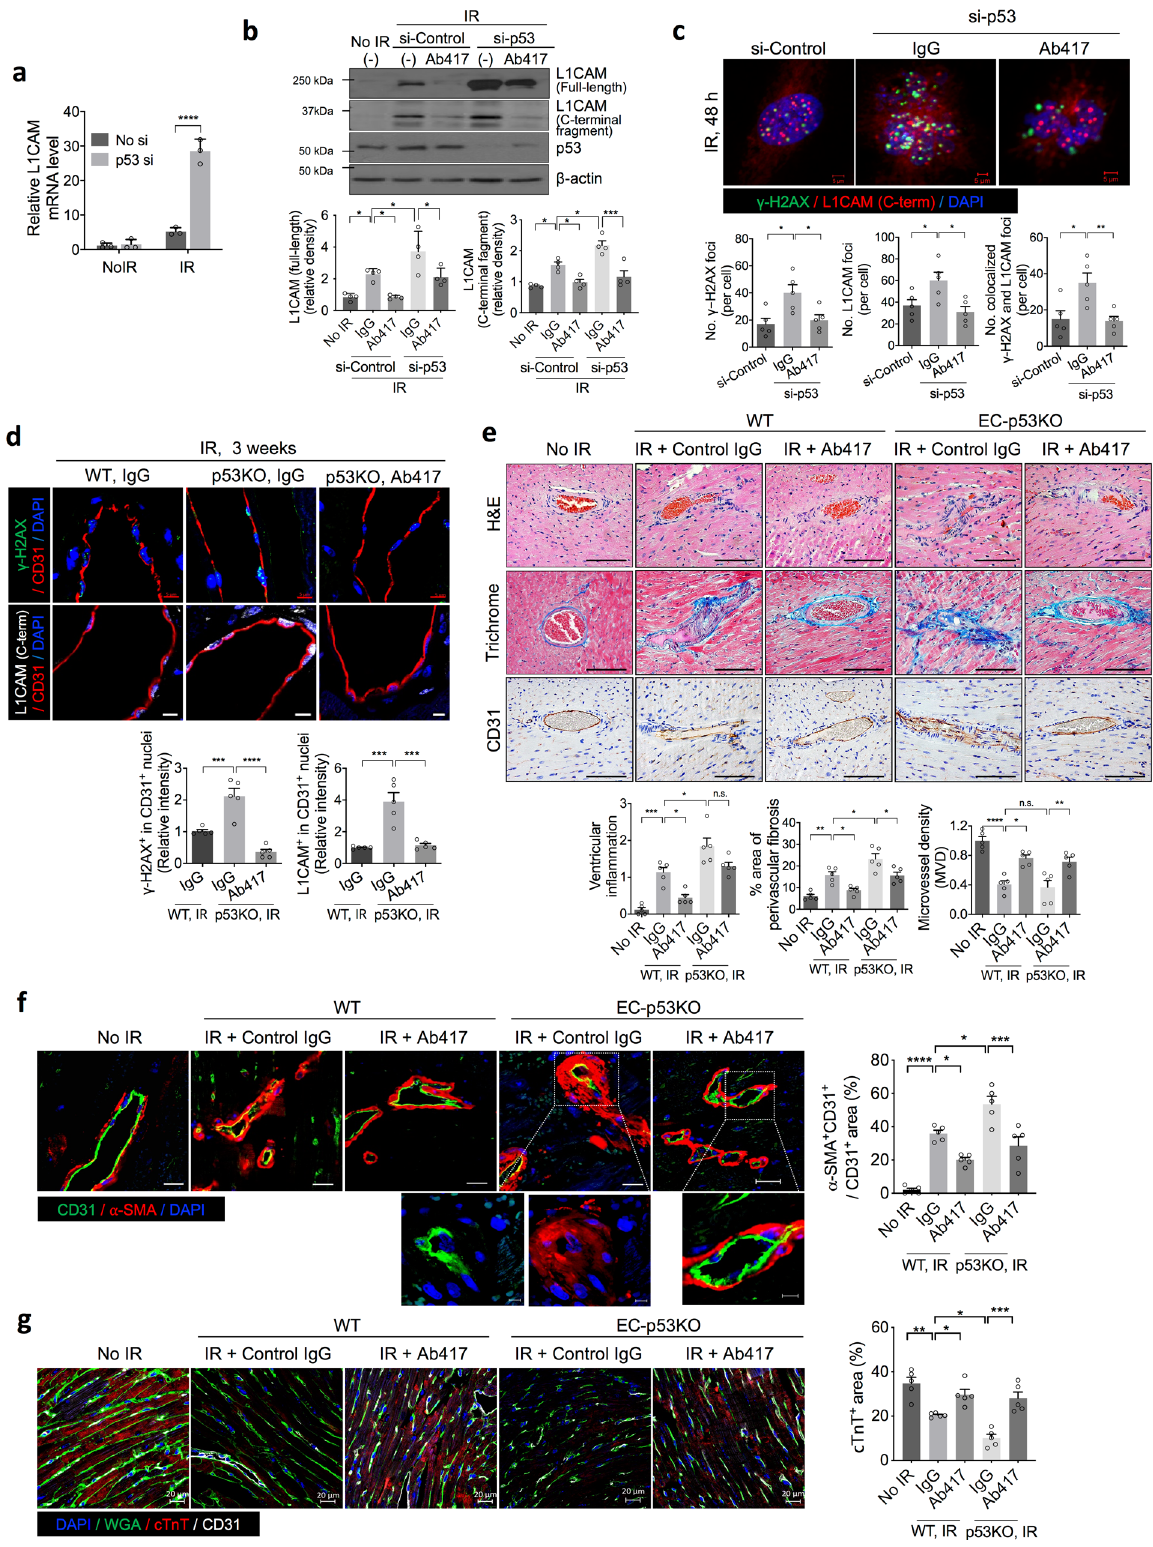
mice (Fig. 4d and Supplementary Fig. 7d). Furthermore, L1-CT was more highly expressed in ECs than in the cardiomyocytes or fi broblasts of either non-irradiated or irradiated mice (Supple- mentary Fig. 7d, e). EndMT and TnT loss in hypoxic cardio- myocytes occurred in irradiated mice, but these effects were reduced by Ab417 treatment (Fig. 4e and Supplementary Fig.